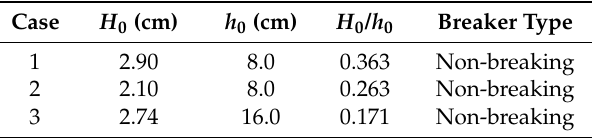
Table 2. A list of experimental